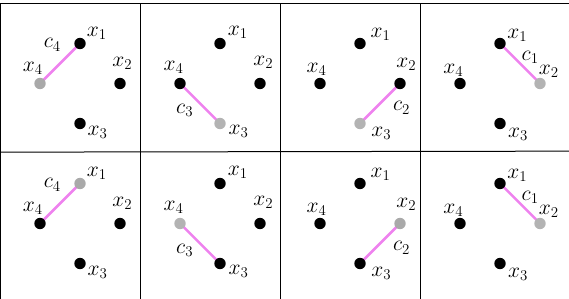
Figure 12: The collection of 3 -rooted forests for C 4 .